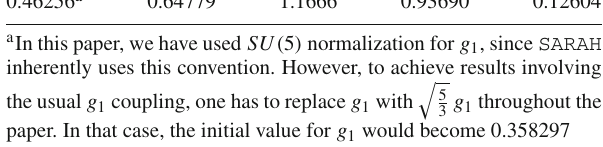
Table 1 Initial values for different SM parameters required for RG evolution at electroweak (EW) scale g